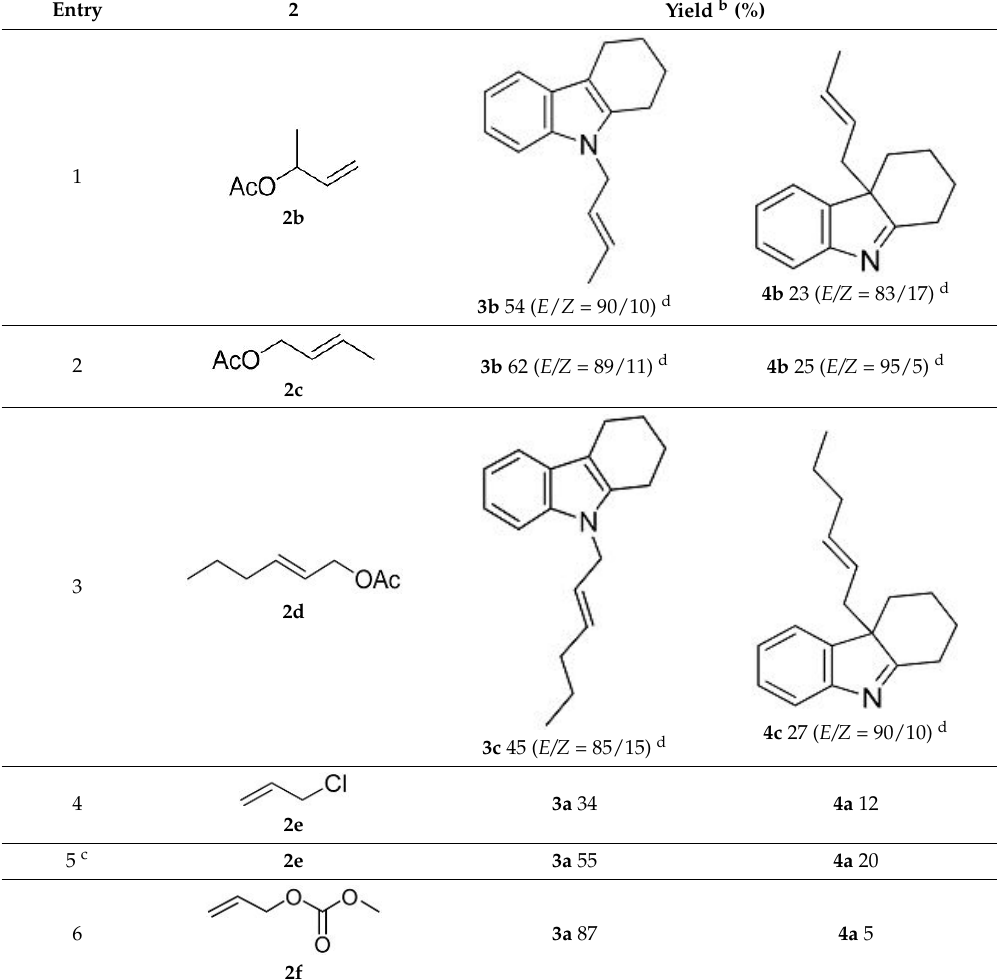
Table 2. Reaction of 1,2,3,4-tetrahydrocarbazole ( 1a ) with allylic compounds ( 2b – f ).